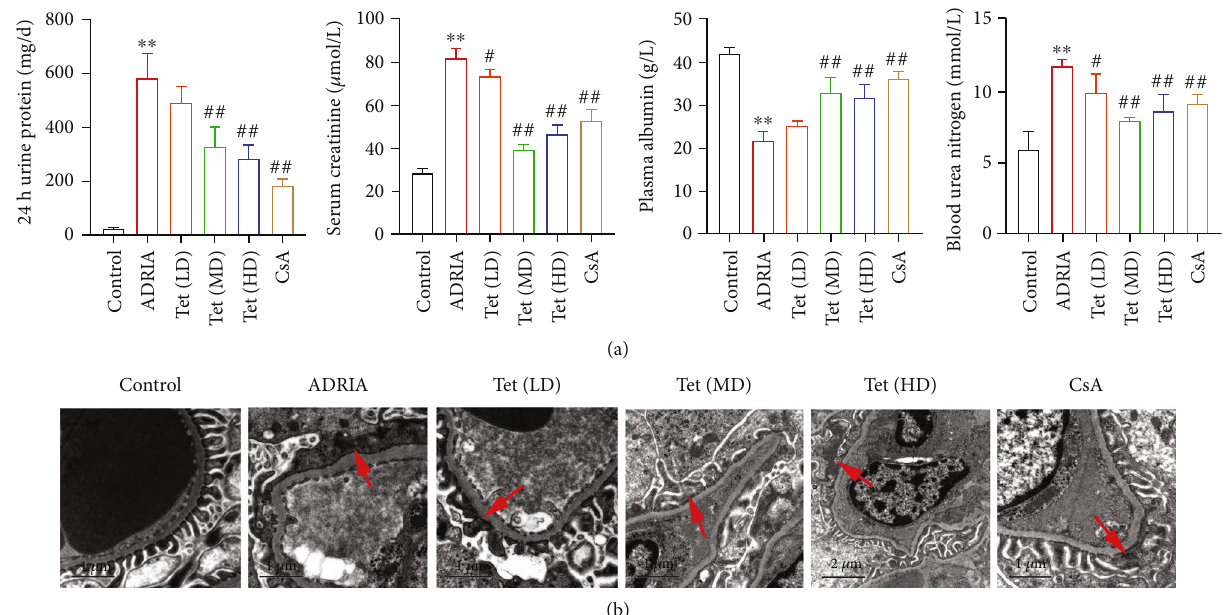
Figure 1: Tetrandrine (Tet) recovers the renal dysfunction and podocyte injury in adriamycin- (ADR-) induced nephropathy rats. (a) The levels of 24-hour urine protein and renal function indexes (serum creatinine, plasma albumin, and urea nitrogen) in rats. ∗∗ P < 0 : 01 versus the control group. # P < 0 : 05 and ## P < 0 : 01 versus the ADRIA group. (b) Process fusion (red arrows) of podocytes was identi fi ed via electron microscopy ( scale bar = 1 μ m). Nephropathy rats were induced by adriamycin (ADRIA) and then treated with low-dose (LD), medium-dose (MD), high-dose (HD) Tet, or cyclosporine A (CsA, a positive